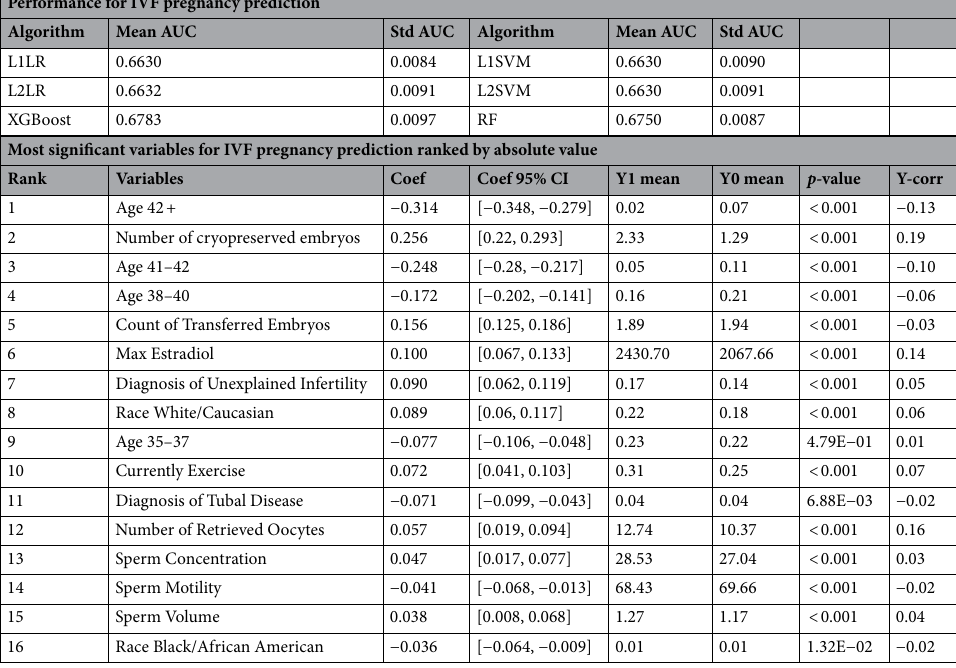
Table 2. IVF pregnancy prediction model: performance metrics and most significant variables. We list the LR coefficients of statistically significant variables (Coef) and their 95% confidence intervals, the correlation of the variable with the pregnancy label (Y-corr), the mean value of the variable (Y1-mean) in the pregnant class, and the mean value of the variable (Y0-mean) in the non-pregnant class. p -values were computed to compare the mean of each variable in the two cohorts (pregnant and non-pregnant) using a two-sided t-test, with the null hypothesis being that the two means are equal.